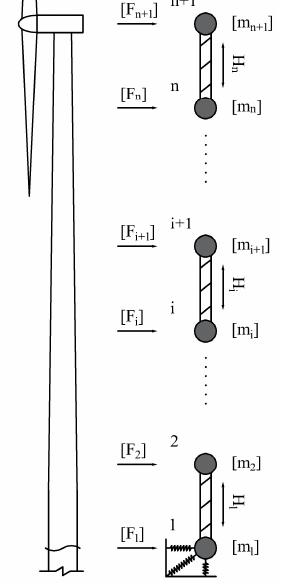
Figure 6. Tower Figure 6. Tower discretization.